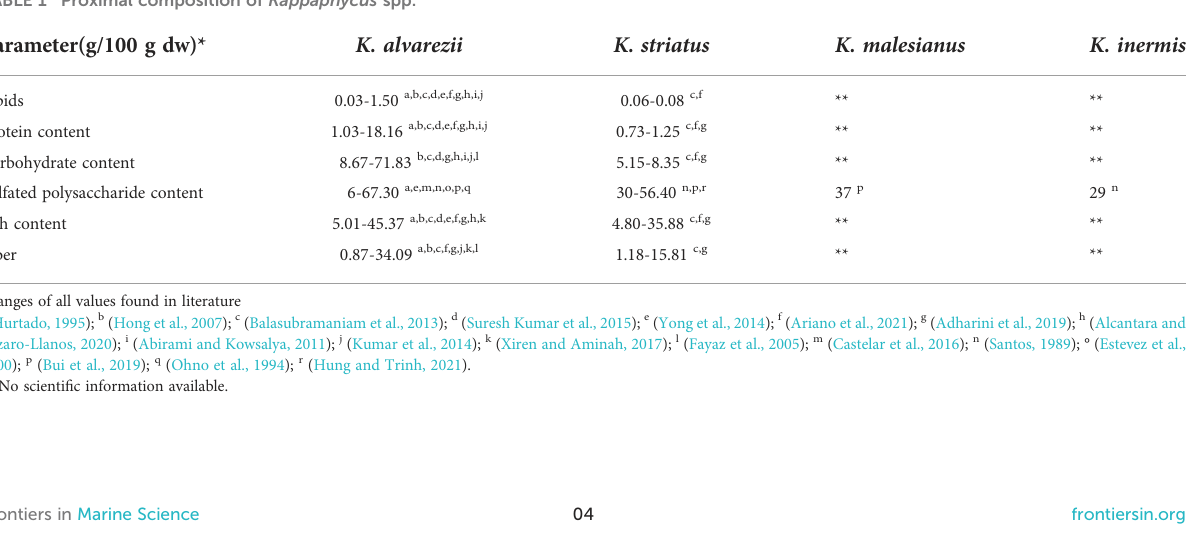
TABLE 1 Proximal composition of Kappaphycus